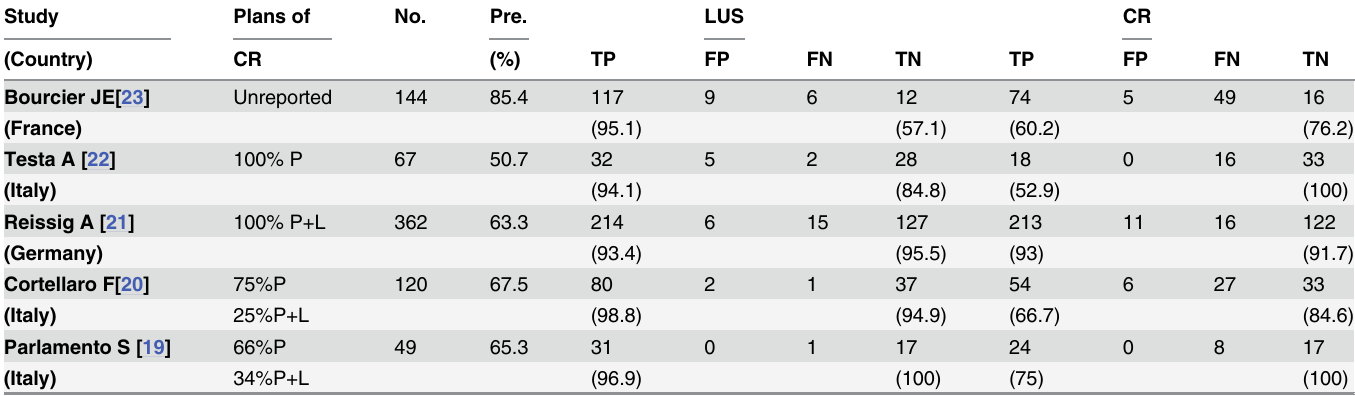
Table 1. The characteristics of included